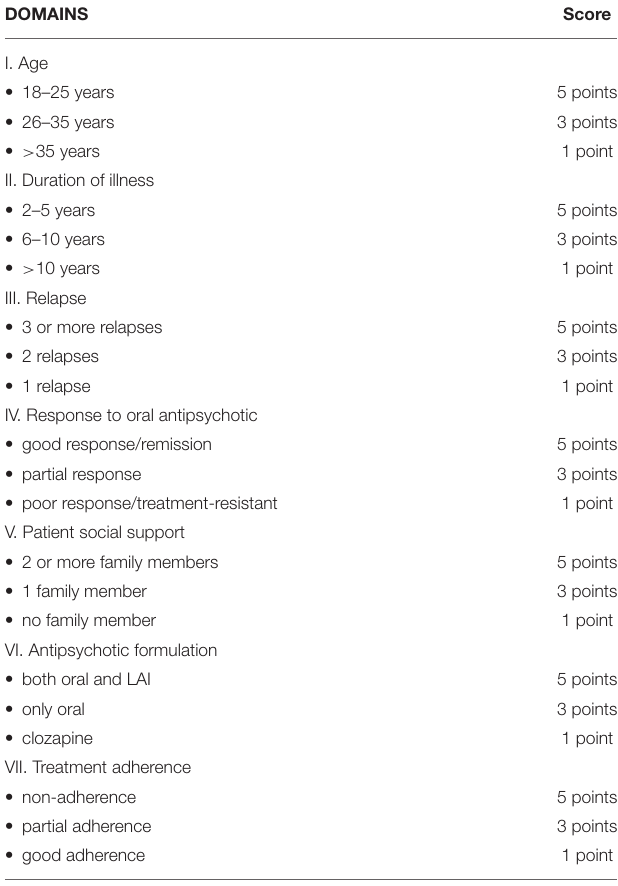
TABLE 1 | Rating opportunity for long-acting injectable antipsychotic initiation index